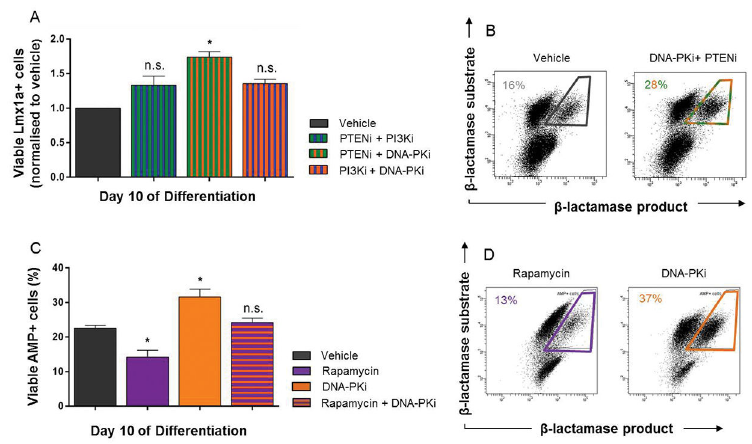
Figure 4. The effect of PI3K and PIKK signaling on Lmx1a+ cells. The involvement of PI3K, DNA-PK and mTOR signaling on the generation of Lmx1a+ cells using FACS is shown in panels A-D. Bar graphs (A and C) were quantified from dot plots, representative plots are shown in panels B and D. During combination experiments with modulators of PI3K and DNA-PK, large variability in the number of Lmx1a+ cells were observed, therefore, data for these experiments is expressed as fold difference from vehicle control. Column graphs expressed as mean ± SEM of at least three independent experiments. ***p<0.001, **p<0.01 and *p<0.05, one-way ANOVA with Bonferroni’s post-hoc test, n=3. doi: